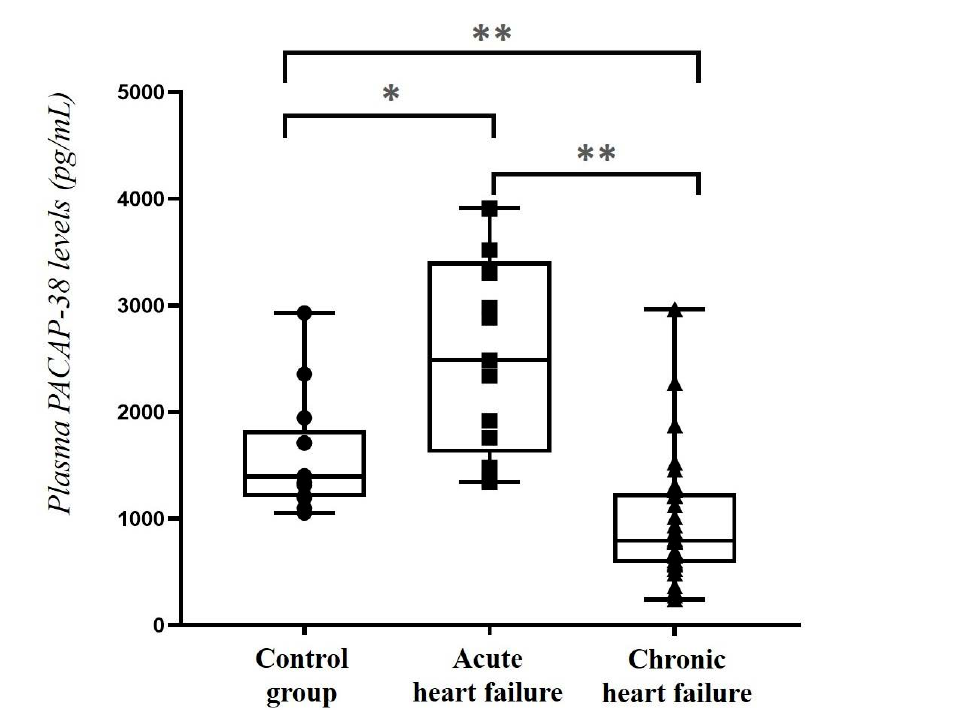
Figure 1. Plasma PACAP-38 levels in acute (decompensated) ( n = 13) and chronic (compensated) ( n = 33) heart failure patients compared to the control group ( n = 13). The box plot diagram represents the interquartile range and median values. The individual values are presented with black dots (control group), squares (acute HF) or triangles (chronic HF). Statistical analysis was performed with one-way ANOVA with Tukey post-hoc test. * p < 0.05, ** p < 0.001.